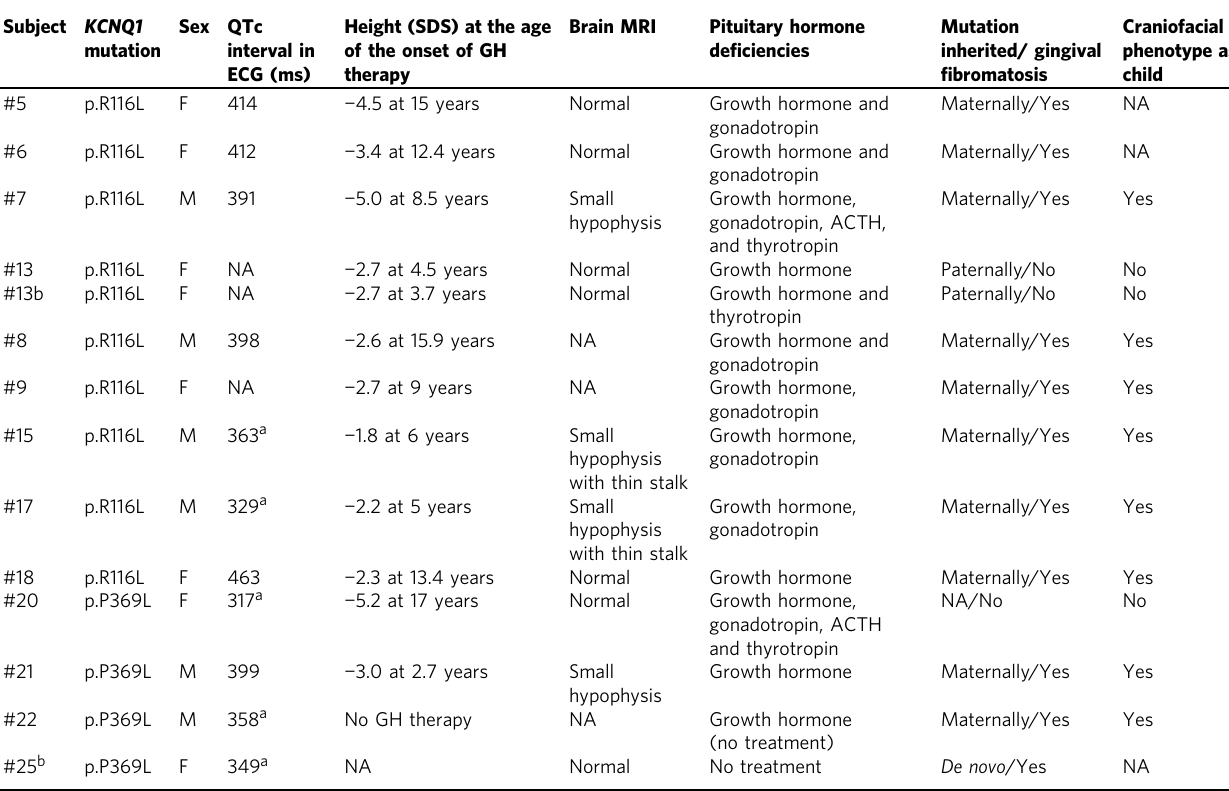
Table 1 Summary of phenotypic features in patients with KCNQ1 mutations p.(Arg116Leu) or p.(Pro369Leu) and pituitary hormone de fi ciencies